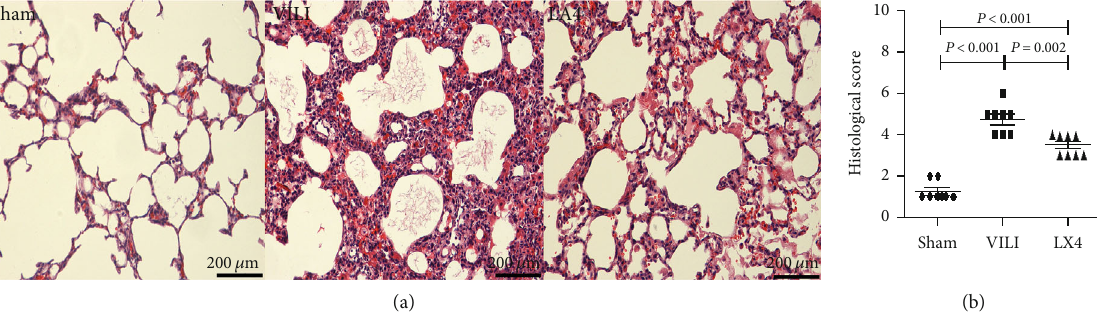
Figure 2: Lipoxin A4 reduced the histological injury score in VILI. After 4 hours of large-volume MV, many in fl ammatory cells in fi ltrated into lung tissue, and the alveolar wall was thickened and broken. There was severe mesenchymal oedema and haemorrhage in the lung tissue in the VILI group (a). Compared to the VILI group, the histological score in the LX4 group was signi fi cantly decreased. The histological injury score is presented in (b). ∗ P < 0 : 05 , vs. the sham group; # P < 0 : 05 , vs. the VILI group. ● : sham group; ■ : VILI group; ▲ : LX4 group.